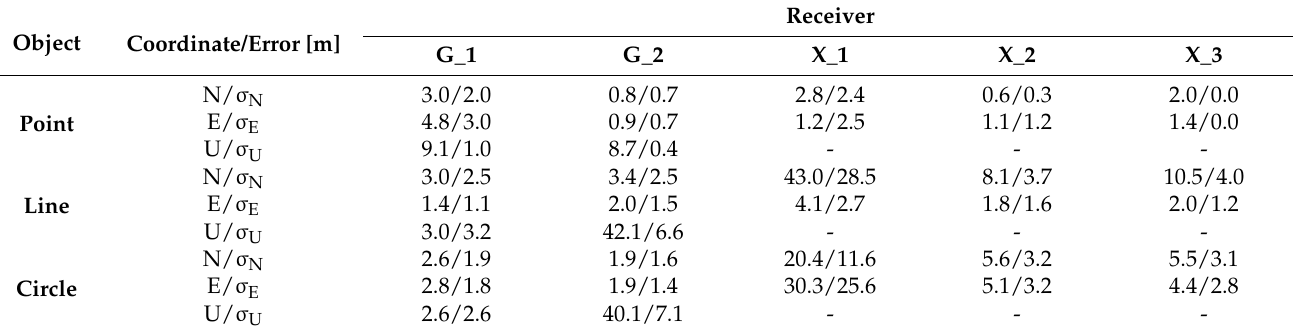
Table 2. Biases of the results obtained (in